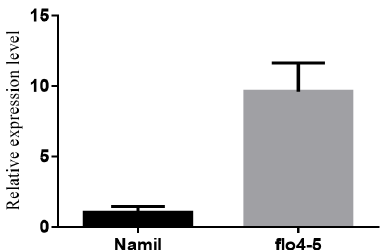
Figure 4. Expression analysis of PPDK between Namil and flo4-5 at 12 DAF. Values shown are mean ± SD (n = 3). Genes 2020 , 11 , x FOR PEER REVIEW 3.5. Mutation of FLO4-5 Changed the Expression Levels of Major Starch Synthesis Enzymes Because the starch content and the starch granules were altered in the flo4-5 mutant, the expression levels of the starch synthesis-related genes in the developing grains were then analyzed using qRT-PCR. Compared with the wild-type Namil, the transcription of several genes decreased in the mutant, including GBSSI , GBSSII , AGPL1 , AGPL2 , AGPL3 , AGPL4 , AGPLS1 , SSI, SSIIa, SSIIIa, SSIIIb, SSIVa, SSIVb, BEI, BEIIa, BEIIb, and PUL . The expression of AGPS2a , AGPS2b , SSIIb , and SSIIc increased in the mutant compared to the wild type, with substantial increases seen for AGPS2a and AGPS2b (Figure 5a). The expression analysis of Suweon 542 ( flo4-4 ) revealed similar expression patterns (Figure 5b).